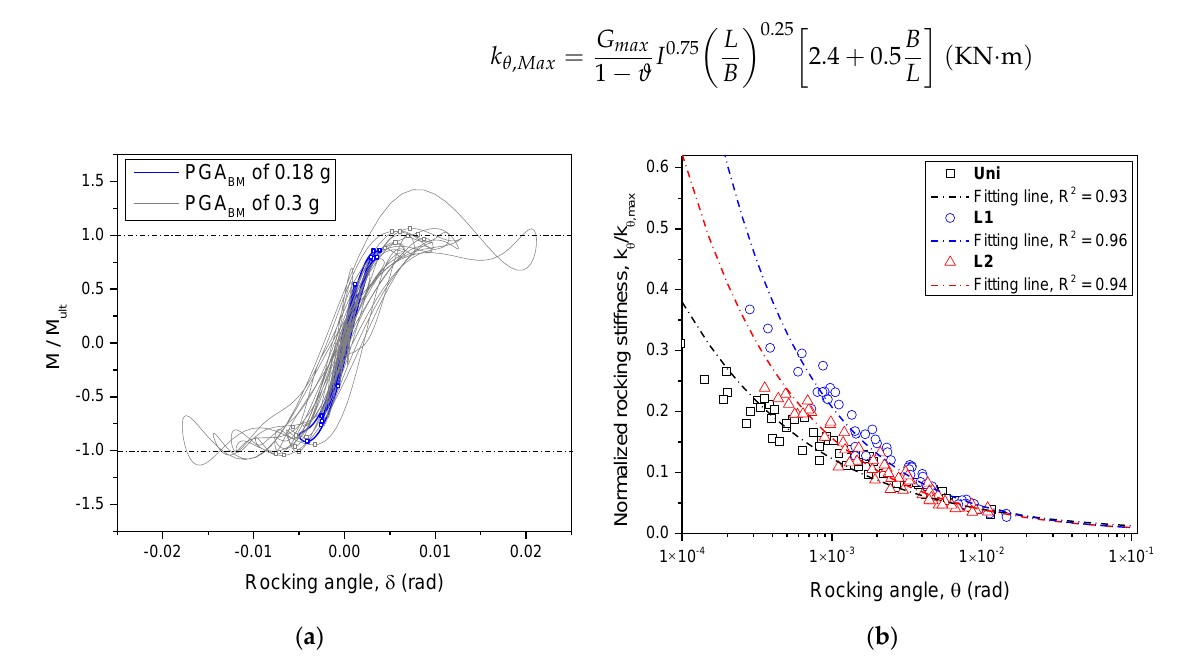
Figure 8. ( a ) Relationship between overturning moment (M) and rocking angle (θ), and ( b ) rocking stiffness for S1 structure on three soil profiles.